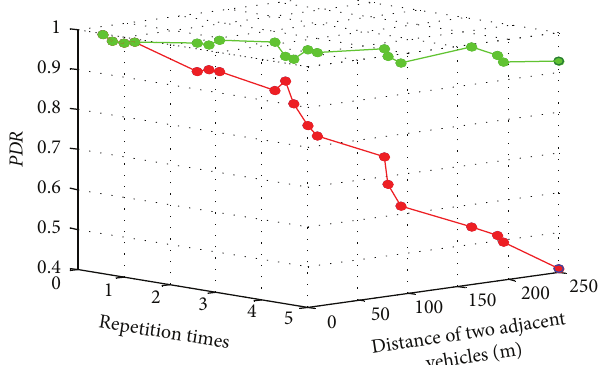
Figure10:The PDR beforeandafterusingrepetitionmodeldecision algorithm (number